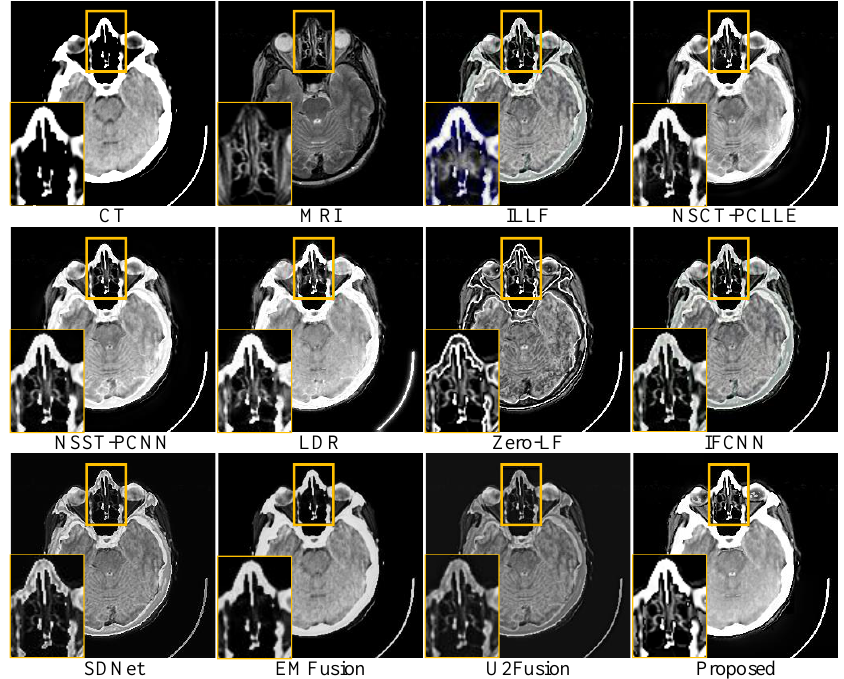
Figure 5. Comparison of performances of various methods on computed tomography magnetic resonance imaging (CT-MRI) source images. For a clear comparison, we select a same region (i.e., the yellow box) in each image and zoom in it in the bottom left corner